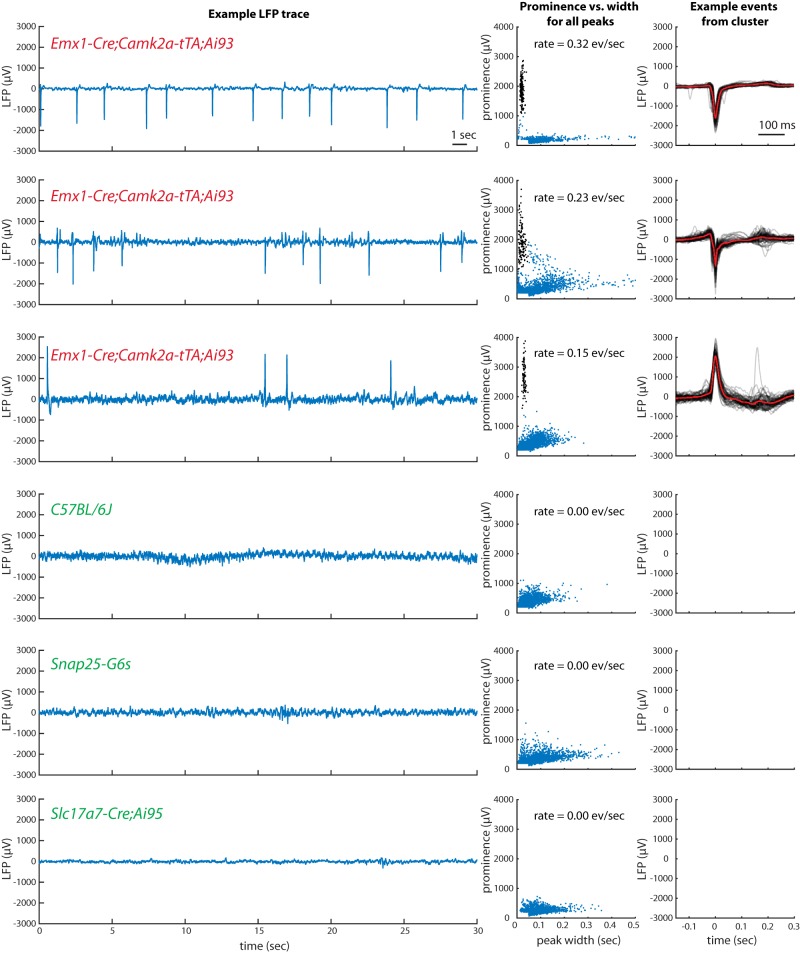
Epileptiform electrical activity in frontal cortex of some GCaMP6-expressing mice but not others. Left, each row contains an example segment of raw LFP data from each of six mice, with genotype identified in colored text. Middle, a plot of the prominence versus width of all peaks (see Methods) in the full LFP traces. Points highlighted in black were identified as a distinct cluster and included in the computation of event rate and the example events plotted at right. Right, 50 example events (gray) and the mean of all events (red). For the recording in row C, positive peaks rather than negative were analyzed.